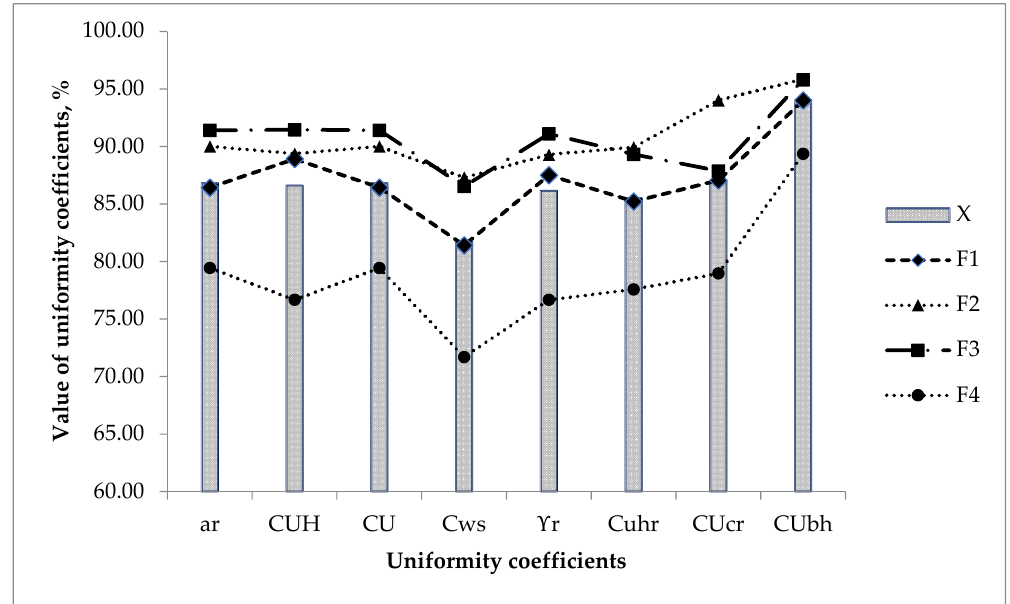
Figure 6. The results of different uniformity coefficients for all experimental fields, for T2 where: ar—coefficient of uniformity according to Oehler, CUH—coefficient of uniformity according to Heerman and Hein, CU—coefficient of uniformity according to Christiansen, Cws—coefficient of uniformity according to Wilcox and Swailes, γ r—coefficient of uniformity according to Voigt, CUhr—coefficient of uniformity according to Hart and Raynolds, CUcr—coefficient of uniformity according to Criddle et al., X—average values in individual samples.